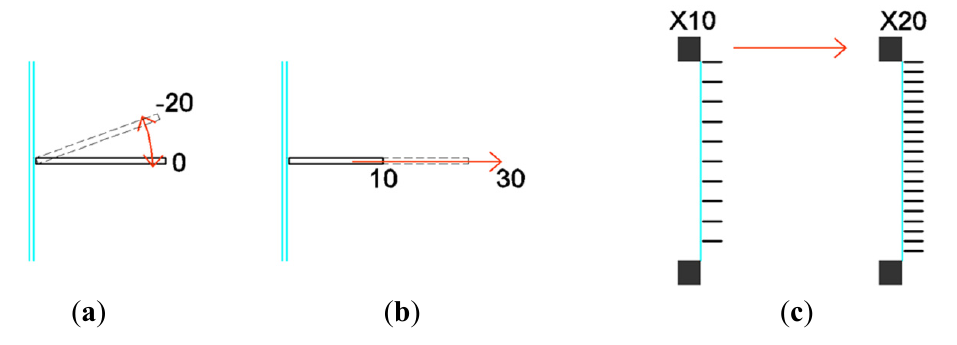
Figure 4. External shading controllers and function associated: ( a ) Angle; ( b )